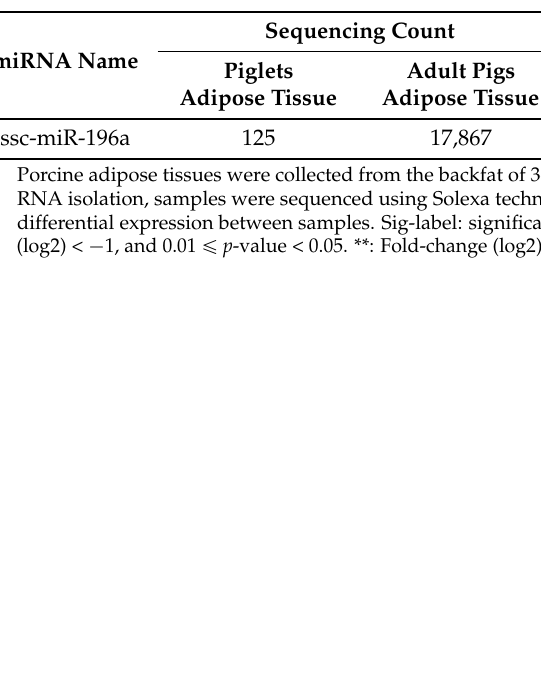
Table 1. Expression of miR-196a in developing adipose tissues of